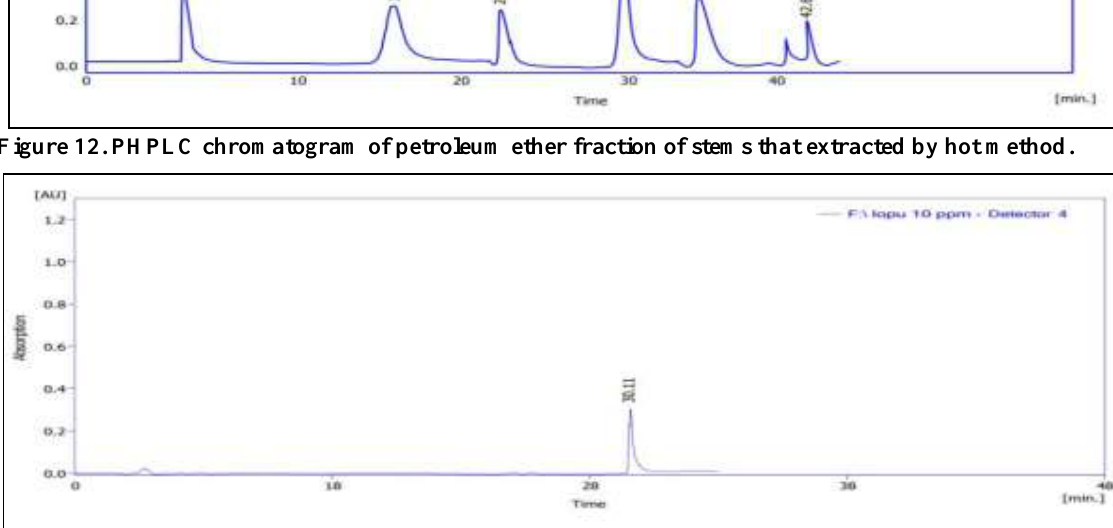
Figure 13. PHPLC chromatogram of standard lupeol.